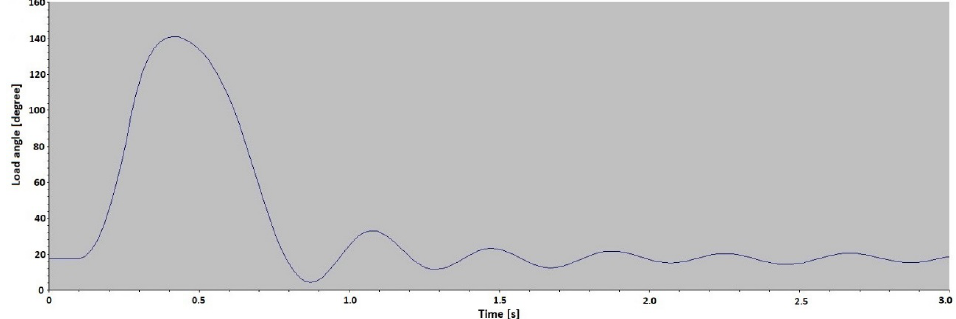
Figure 21. Simulation results of the load angle of Generator 2 during the three-phase fault with the fault duration of 170 ms.